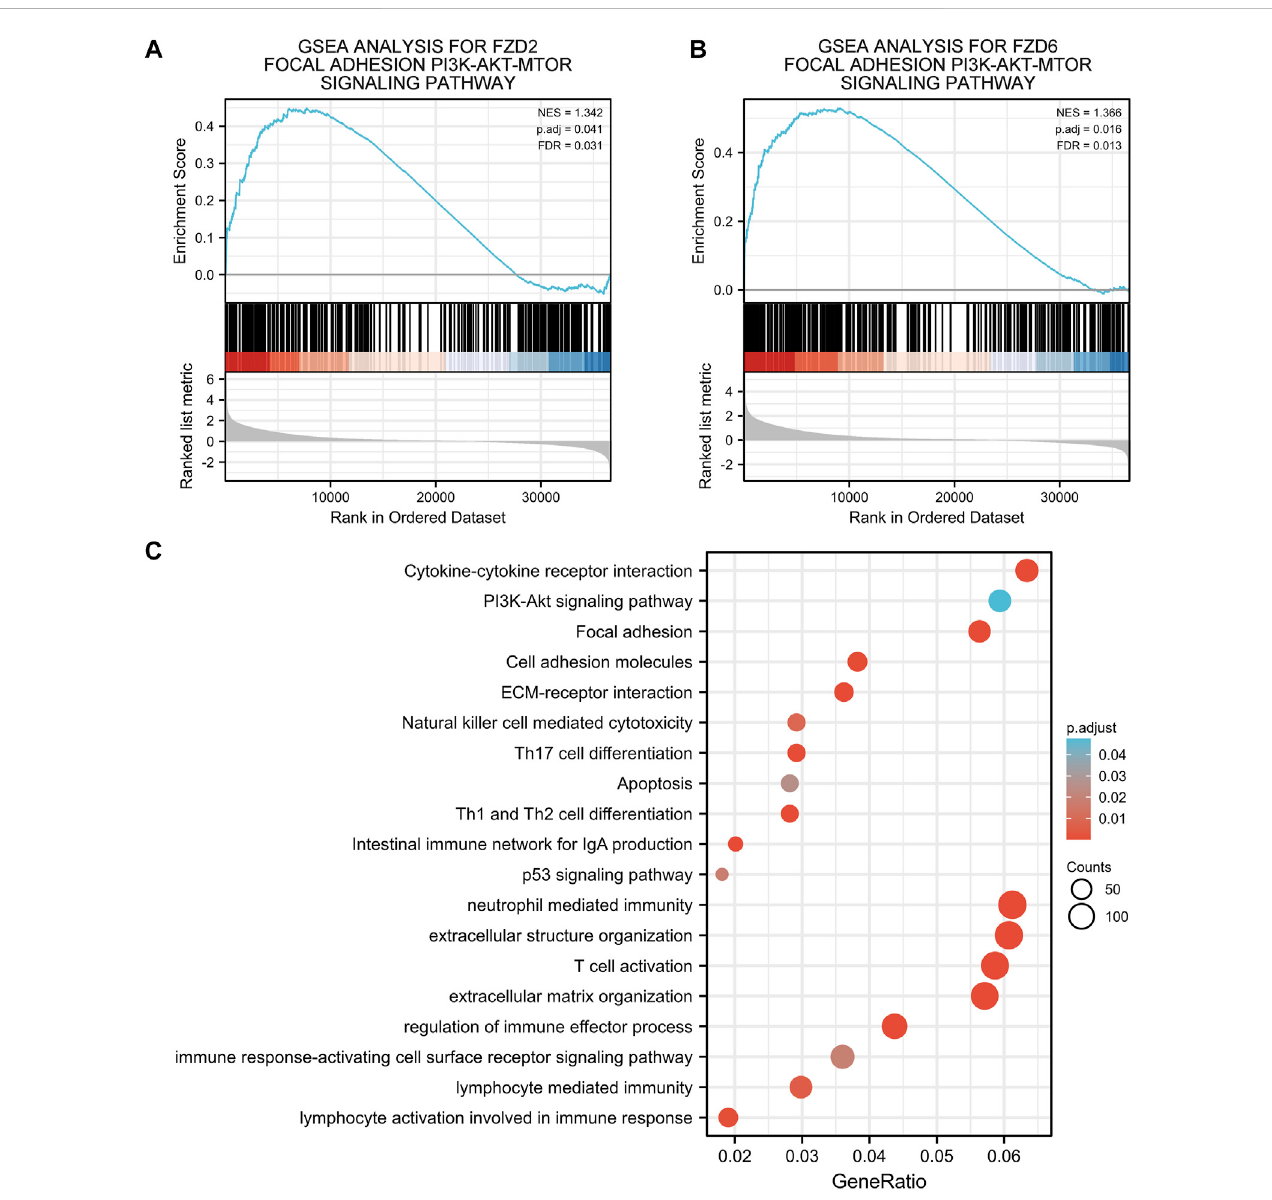
FIGURE 7 (A,B) Gene set enrichment analysis of FZD2 and FZD6. (C) Gene ontology and Kyoto encyclopedia of genes and genomes analyses of genes correlated with both FZD2 and